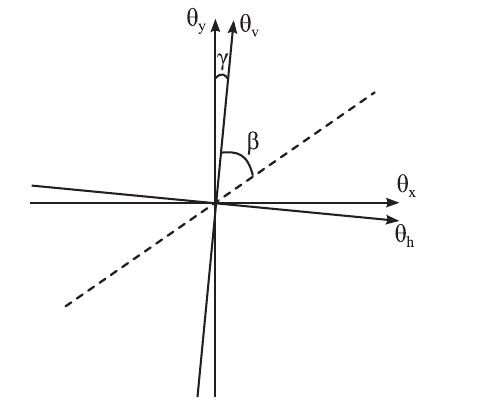
plane.FIG. 8. Azimuthal shift between the coordinate systems of goniometer and crystal. The dashed line shows the plane with an angle (cid:3)